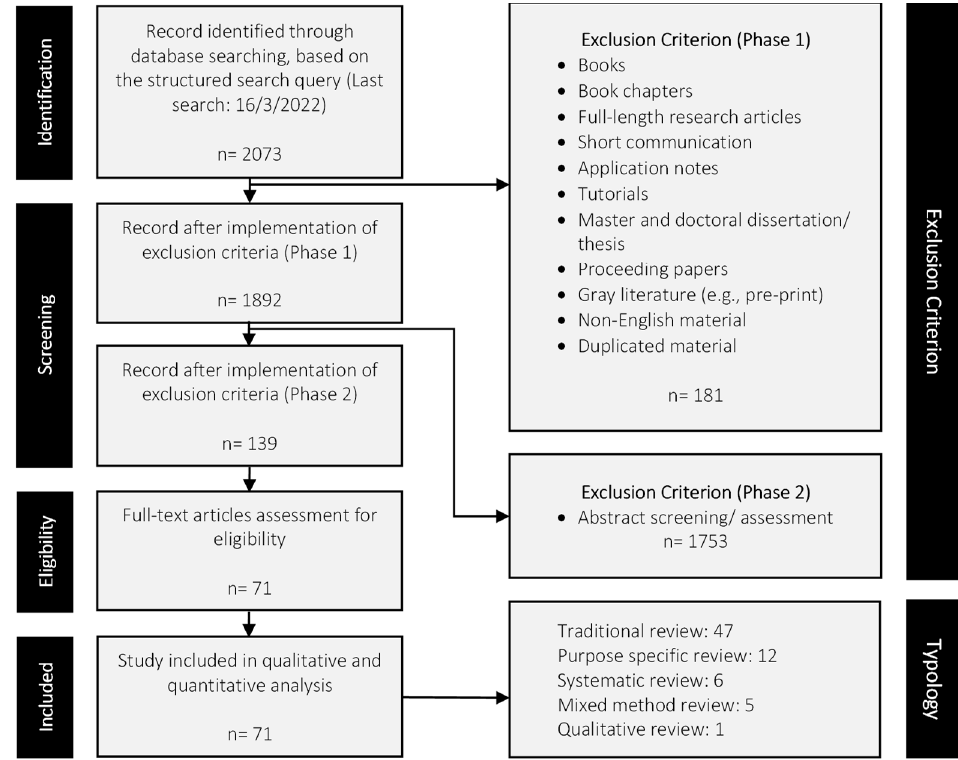
Figure 4. Study selection flowchart based on the PRISMA guidelines [53].